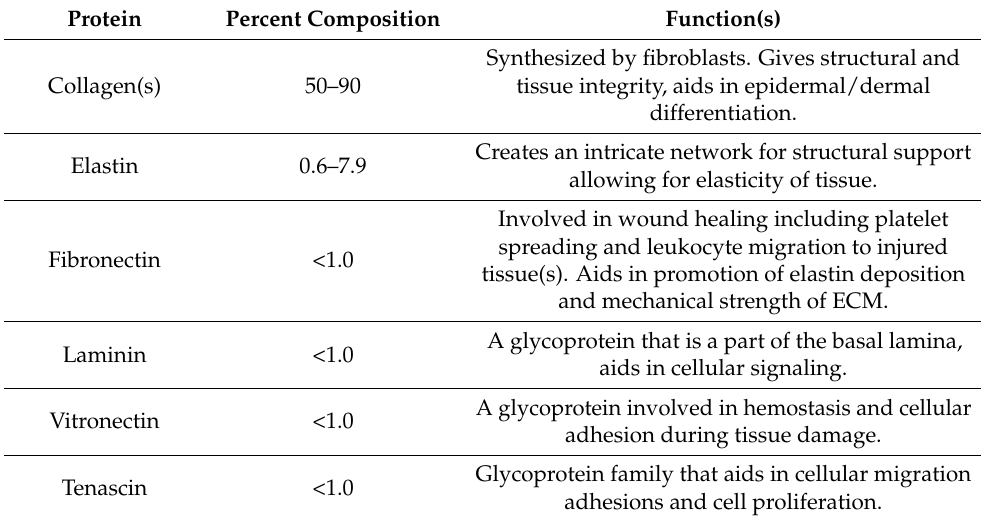
Table 2. Listing of proteins found in ECM, percent composition, and the general functions within the ECM of the integument. Note that varying degrees of composition can occur because of the location of ECM. Protein Percent Composition Function(s) Synthesized by fibroblasts. Gives structural and Collagen(s) 50–90 tissue integrity, aids in epidermal/dermal differentiation. Creates an intricate network for structural support Elastin 0.6–7.9 allowing for elasticity of tissue. Involved in wound healing including platelet spreading and leukocyte migration to injured Fibronectin <1.0 tissue(s). Aids in promotion of elastin deposition and mechanical strength of ECM. Laminin <1.0 Vitronectin <1.0